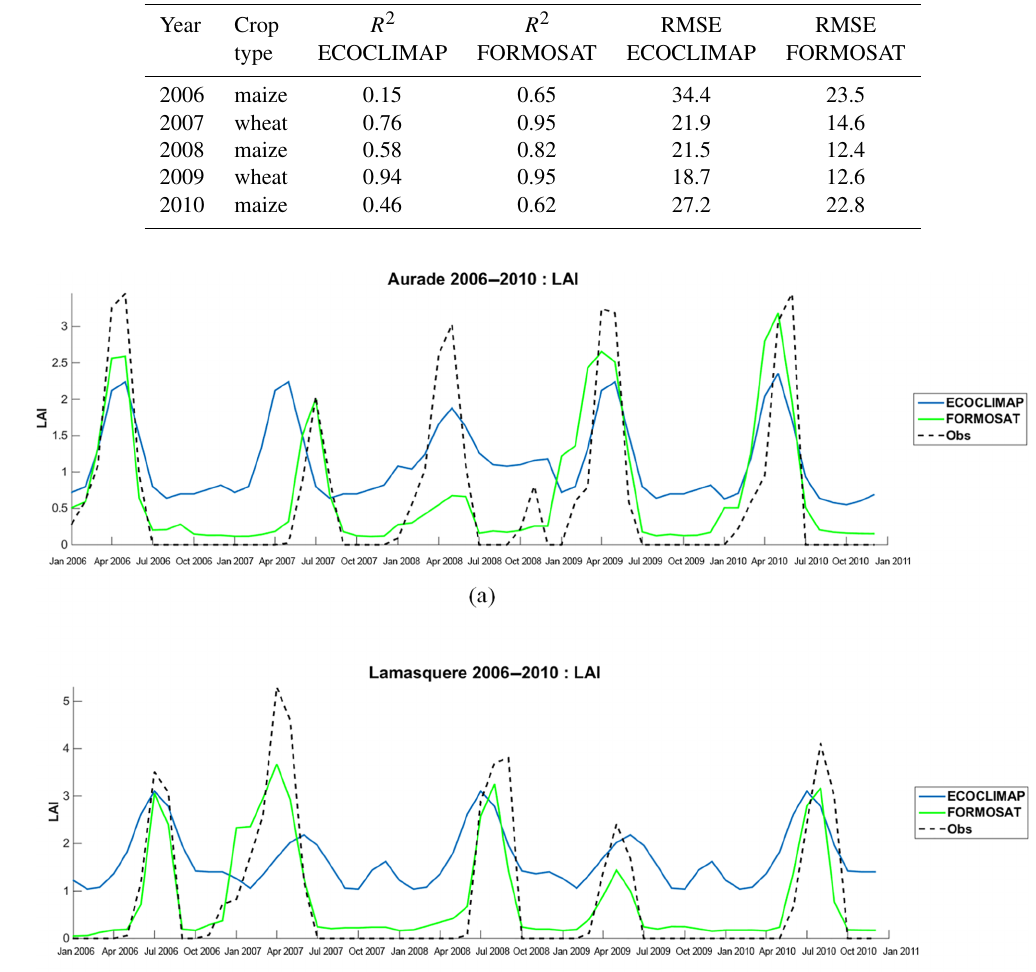
Table 3. Correlation coefficient and RMSE of evapotranspiration for the Lamasquère site.